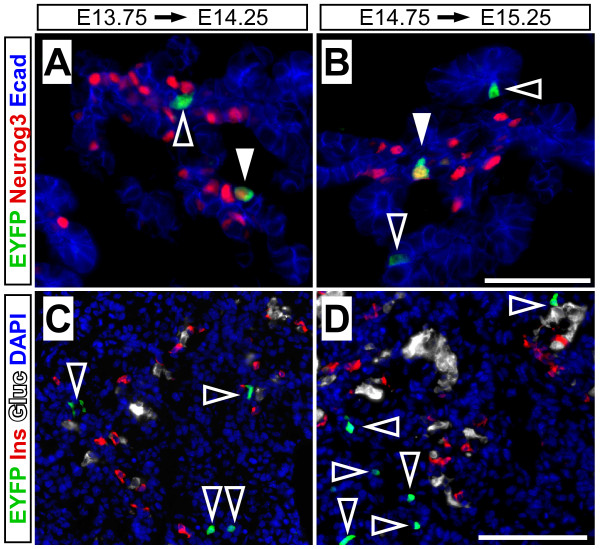
Neurog3+ cells arise from Muc1+ ductal cells during embryogenesis. To detect the short-term differentiation potential of Muc1+ cells, Muc1IC2/IC2; Rosa26EYFP/+ embryos were labeled by TM administration to pregnant dams at E13.75 (A, C) or E14.75 (B, D), and harvested ~12 hours later for immunofluorescence analysis (n = 2 for each timepoint). (A-B) Short-term labeling of Muc1+ cells (green) reveals their presence within the E-cadherin+ ductal network (blue, open arrowheads), as well as their contribution to Neurog3+ cells (red, closed arrowheads). (C-D) Similar analysis of islet hormone expression indicates that Muc1IC2 labeling (green, open arrowheads) is excluded from insulin+ (red) and glucagon+ cells (white), confirming that these cells derive from Muc1+ progenitors but do not themselves express Muc1. Scale bars: 50 μm in A-B and 100 μm in C-D.